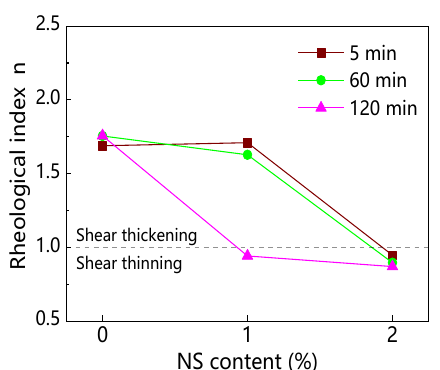
Figure 12. Influence of NS on rheological index ( n ) .